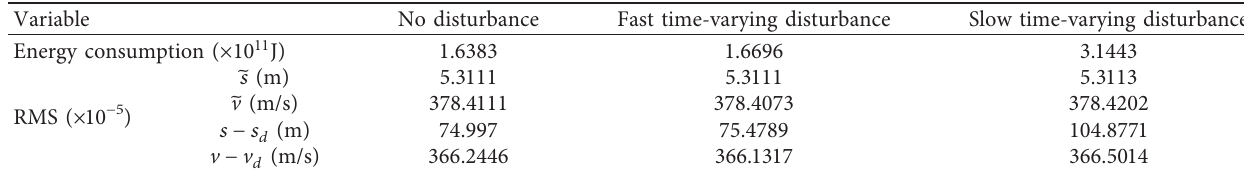
Table 4: Energy consumption and RMS for different environmental